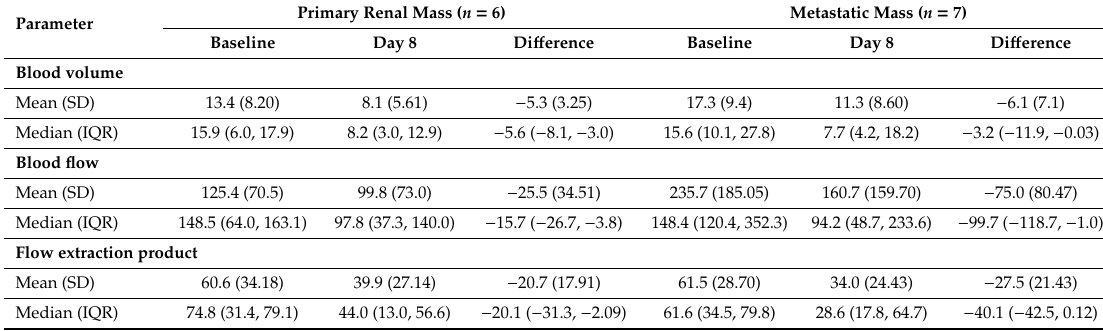
Figure 3. Spaghetti plots for each CT perfusion measure by tumor location: Metastasis versus primary renal mass. ( a ) blood flow (mL / 100 mL / min); ( b ) blood volume (mL / 100 mL); ( c ) flow extraction product (mL / 100 mL / min). Table 2. CT perfusion parameter values by tumor